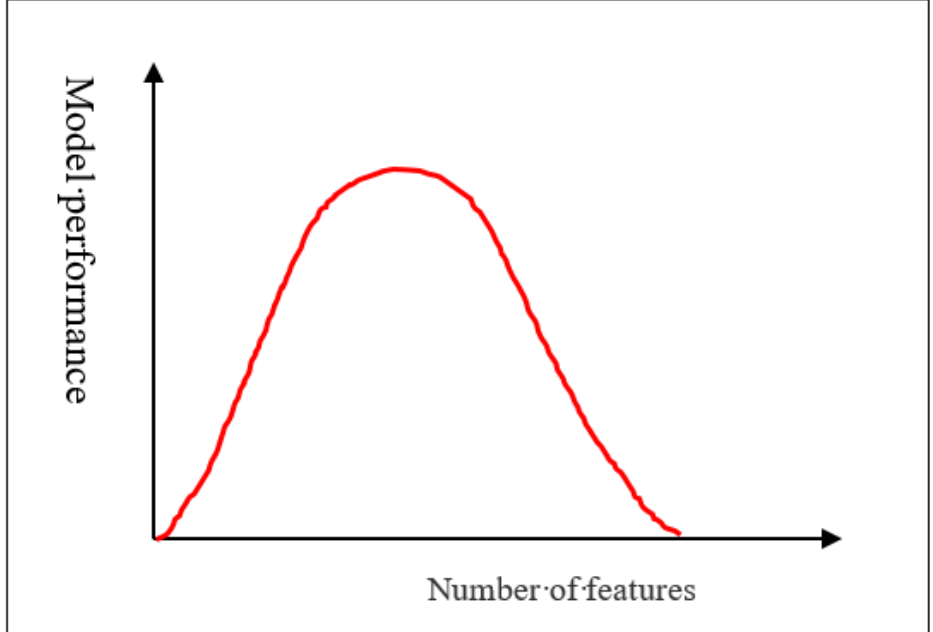
Figure 4. Relationship between model effect and number of features. In this work, combined with the results of the data analysis, the characteristics and types of different BIM elements obtained are shown in Table 2. The final selection of 6 features, including two character features: Is External, Is Load Bearing, represent whether it is outside and whether it is load bearing, respectively; four numerical features including Length, Cross Section Area, Volume and Number of Cartesian points represent Length, Cross Section Area, Volume and Number of Cartesian points, respectively. Perimeter and Area have not been retained, since the two corresponding columns have almost zero attributes out of the four elements we have chosen to